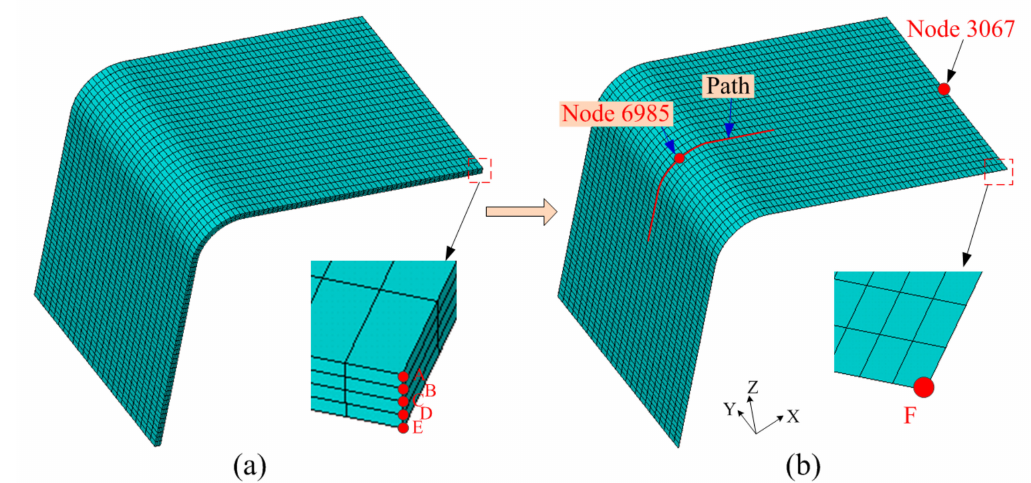
Figure 8. Magnetic force conversion from ( a ) solid element to ( b ) shell element.